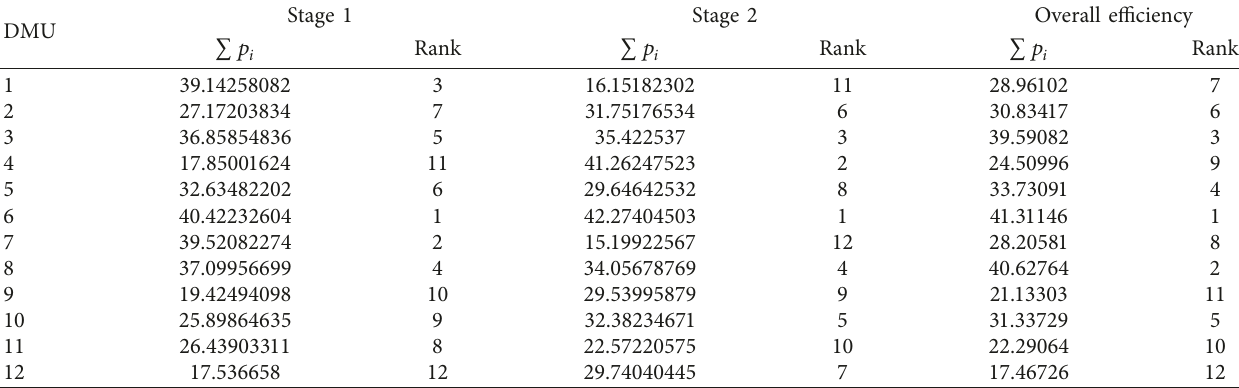
Table 8: Ranking of DMUs based on overall interval efficiency and interval efficiency of stages 1 and 2.